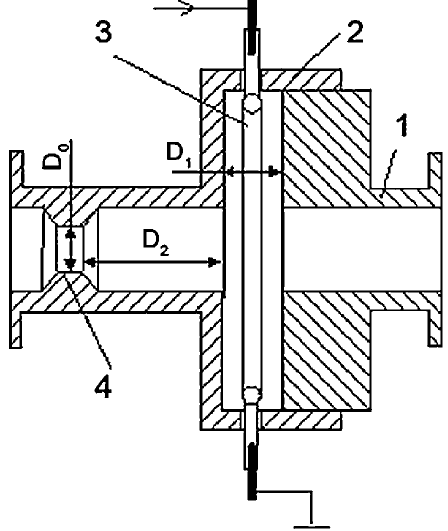
FIG. 2. Plasma switch with active and passive sections, con- taining one gas-discharge tube: (1) circular waveguide; (2) stepped widening; (3) gas-discharge tube; (4) overcritical narrowing